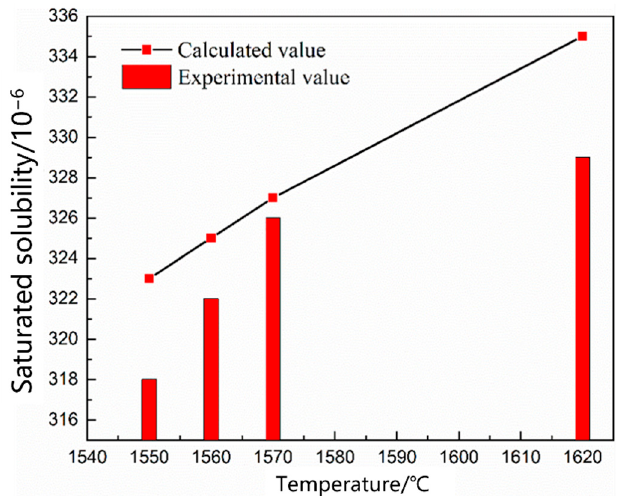
Figure 3. Effect of temperature on nitrogen solubility.